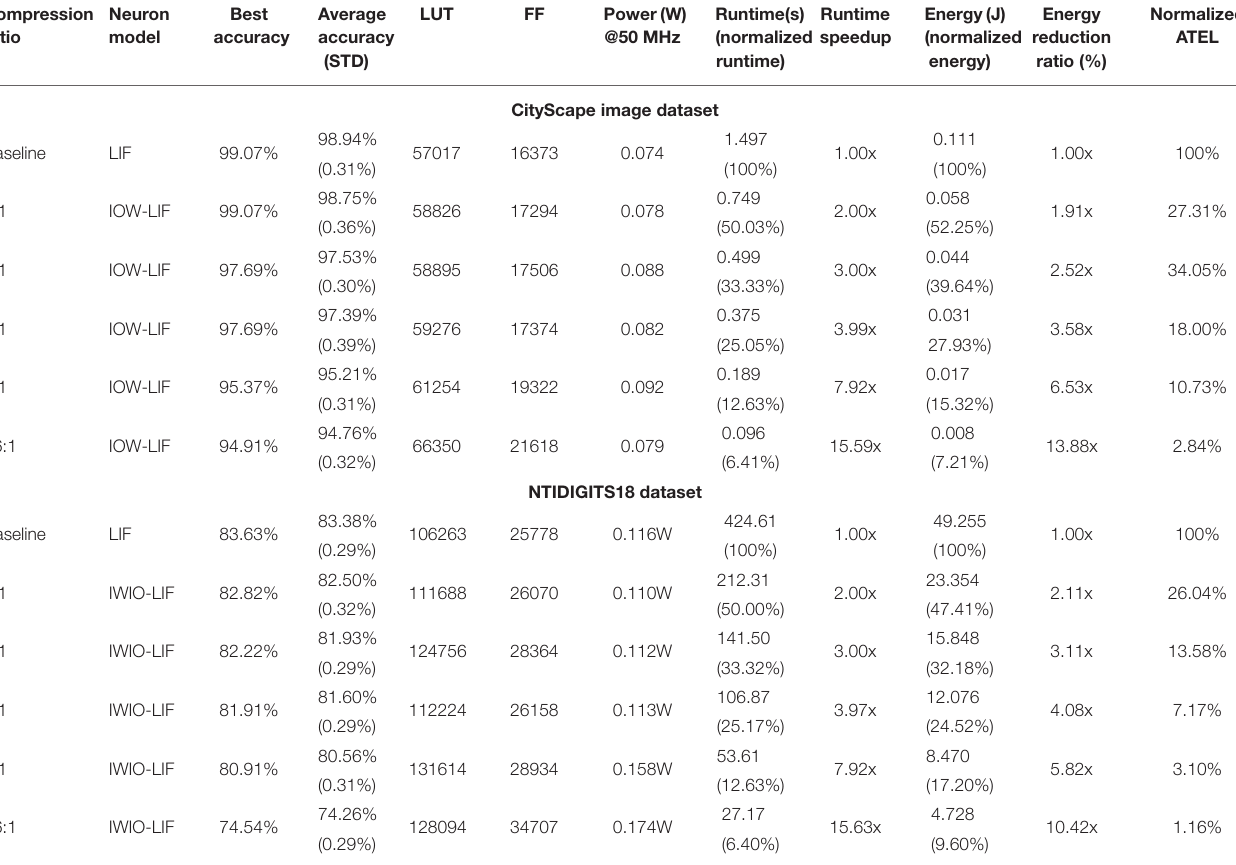
TABLE 2 | Comparison of the baseline and TC-SNN accelerators with IOW LIF neurons based on the CityScape image dataset and the NTIDIGITS18 dataset. Compression Neuron Best Average ratio model accuracy accuracy